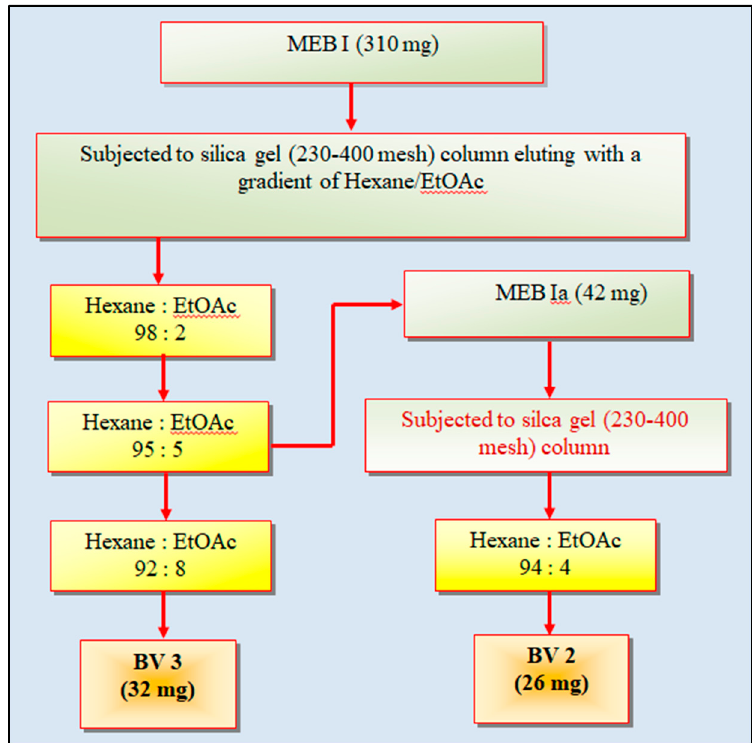
Figure 2. Column chromatography of fractions MEB1 and MEB1a obtained from column chromatography of methanol extract (MEB) of bark of Bauhinia variegata L. BV2 and BV3 are the pure fractions obtained, subjected to further characterization.